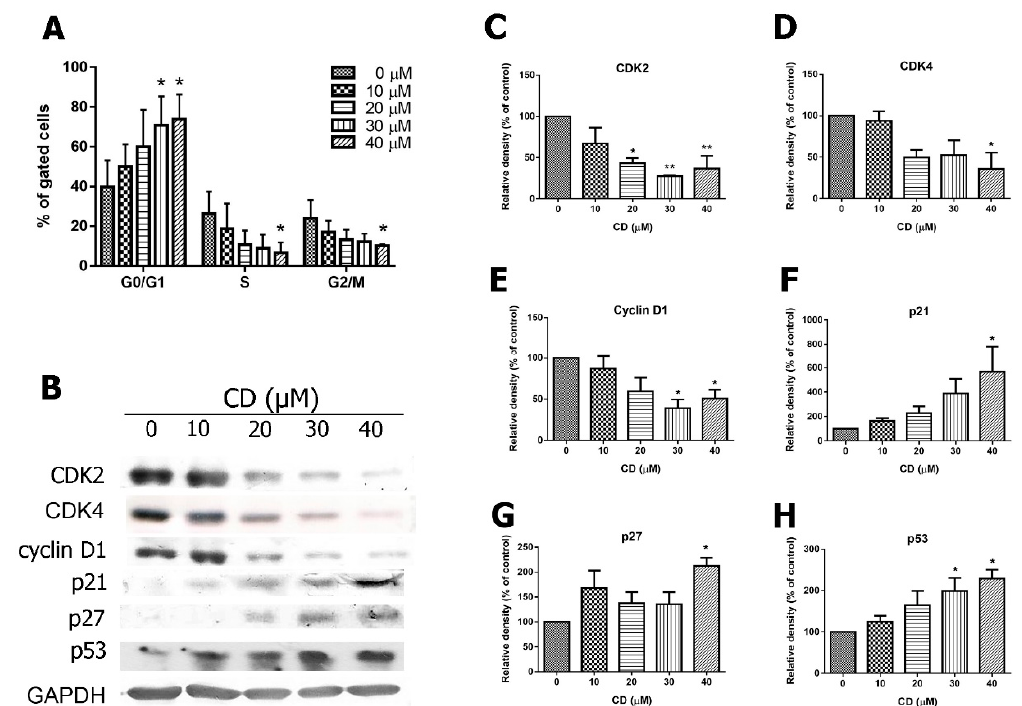
Figure 6. Effects of CD on cell cycle distribution and cell cycle-related protein expression. Cells were treated with the indicated concentrations of CD for 24 h. ( A ) Quantification data of flow cytometry staining with PI. ( B ) Protein expression of p21, p27Kip1, p53, CDK2, CDK4, and cyclin D1. ( C – H ) Quantification results of each protein. Bar graphs show values normalised as percentages relative to the control. Data are expressed as mean ± SD of three to four independent experiments. * p < 0.05, ** p < 0.01 as compared with the control group (0 µM).